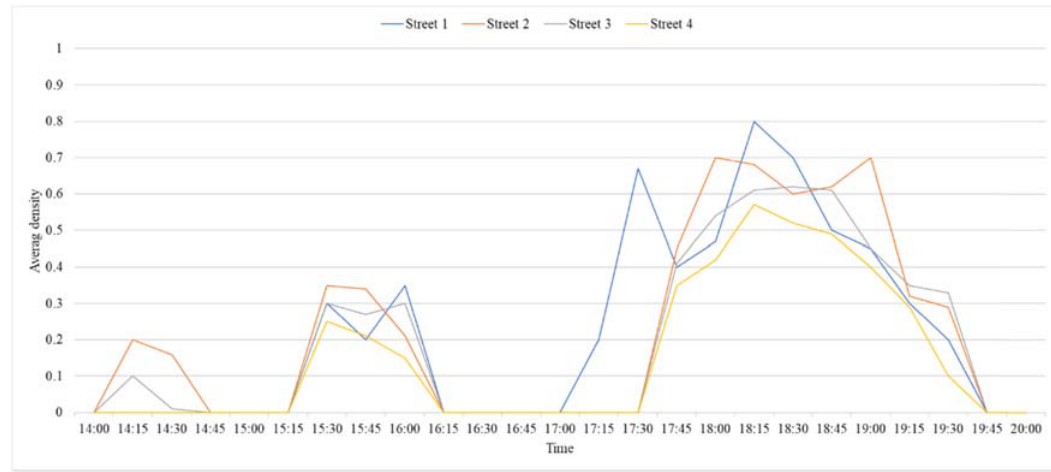
Figure 6: Calculation of average density as a coordinate feature.